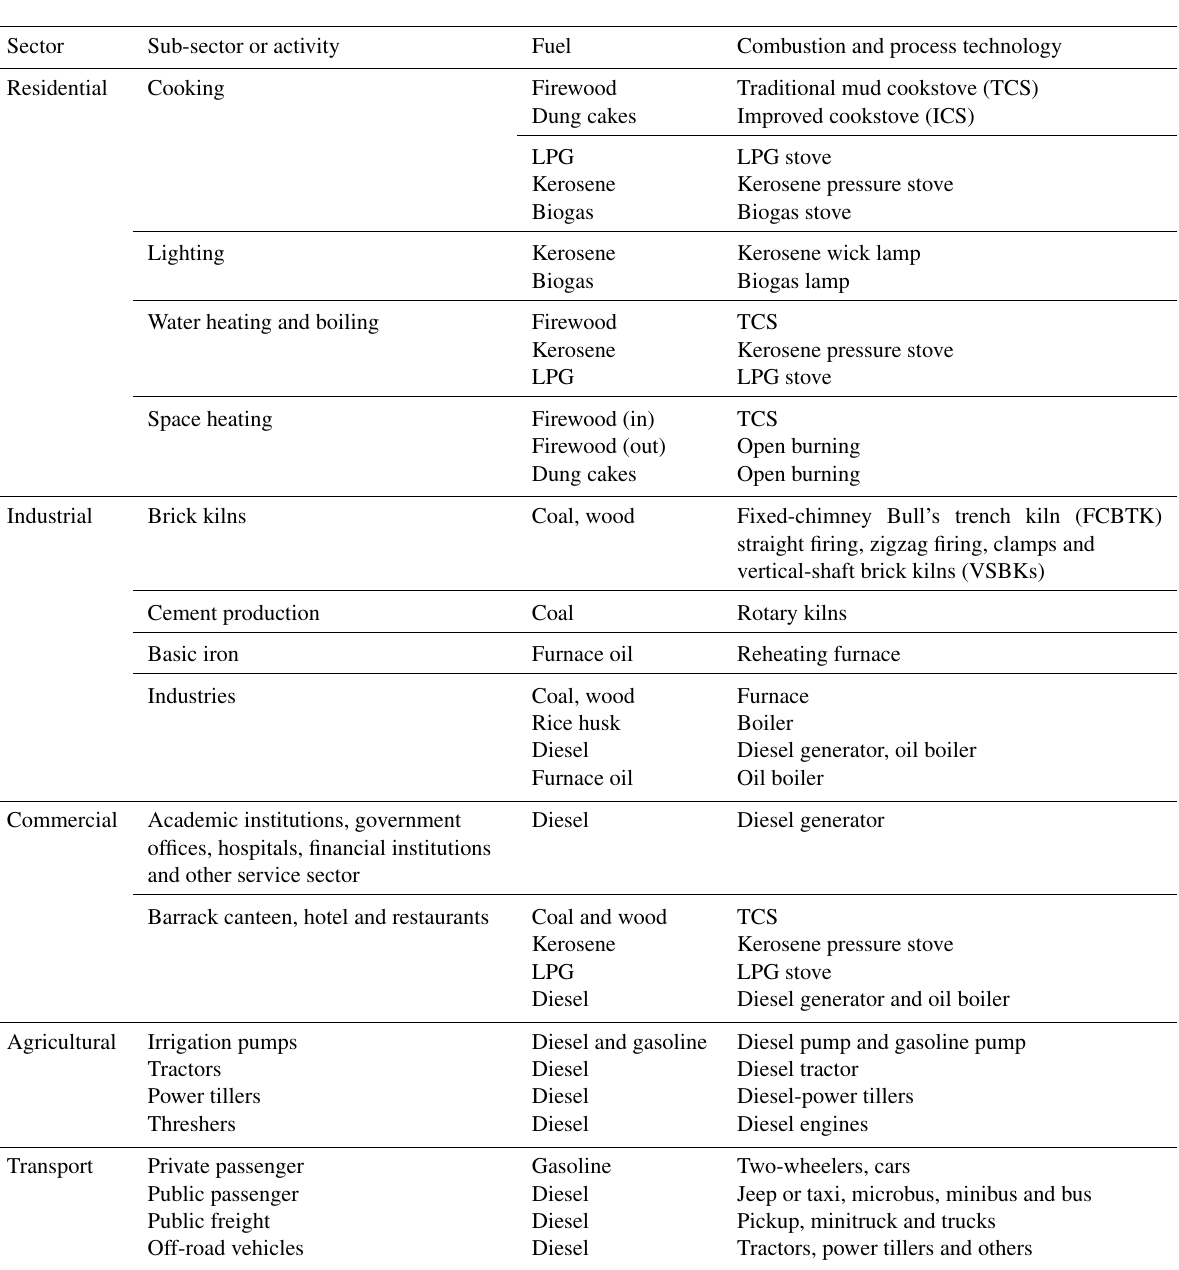
Table 2. Technology details in each sector and